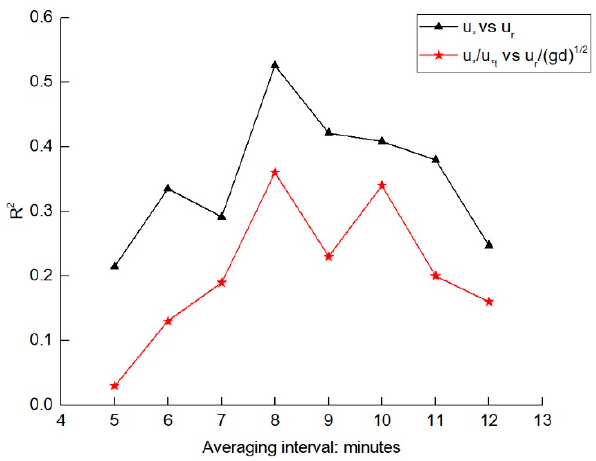
Figure A1. Comparison of coe ffi cients of determination (R 2 ) found using u ∗ or u ∗ / u ∗ t as independent variables with u r or u r / (gd) 0.5 as the respective dependent variables, for averaging intervals of 5 to 12 min. The 8 min interval produced the strongest results in both cases.